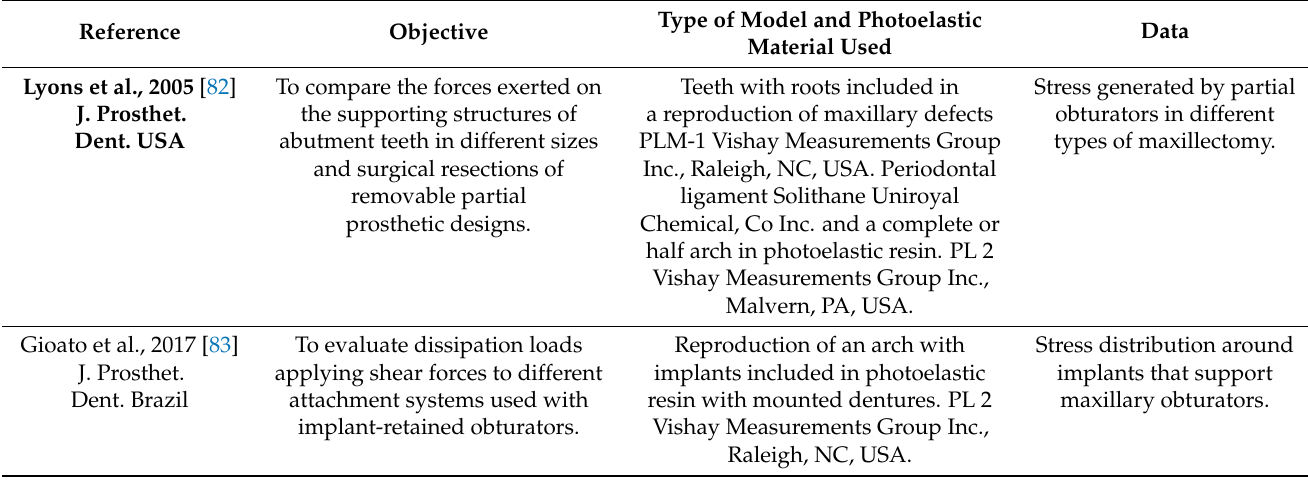
Table 7. Characteristics and findings of implant studies for maxillofacial prostheses in the dental area.